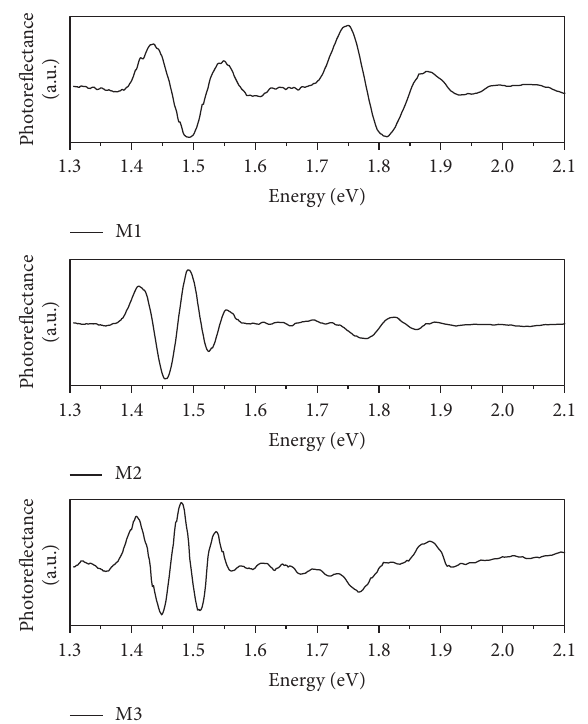
Figure 3: PR spectra of M1, M2, and M3 heterostructures, capped with 25, 60, and 80 nm GaAs layer, respectively. The 375 nm laser was used as modulation